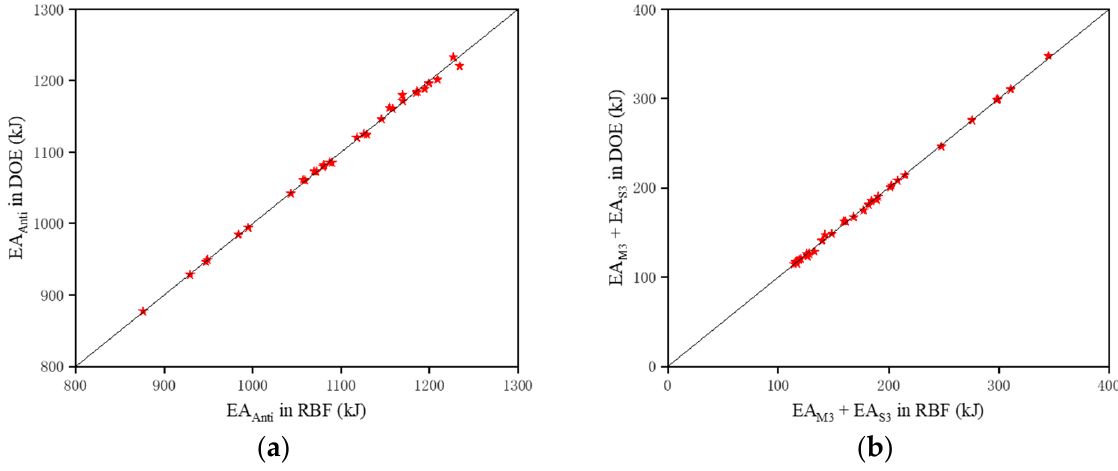
Figure 22. Regression plot for responses: ( a ) EA Anti ; ( b ) EA M3 + EA S3. In addition, we also used three common evaluation parameters, average relative error (ARE), coefficient of determination (R 2 ), and relative average absolute error (RAAE)